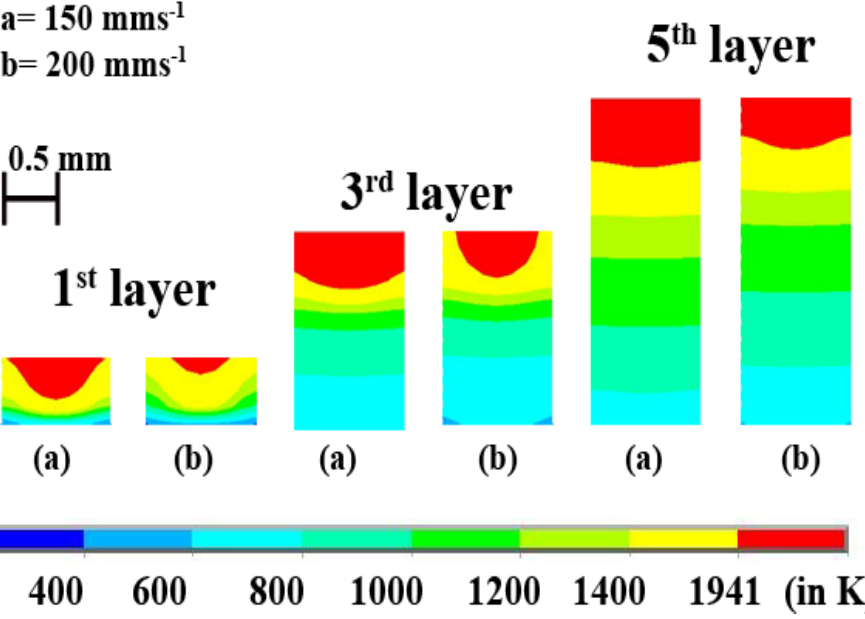
Figure 8. Changing melt-pool shapes for the changing scanning speed for the constant power source of 200 W and scanning speed of ( a ) 150 mm · s − 1 and ( b ) 200 mm · s − 1